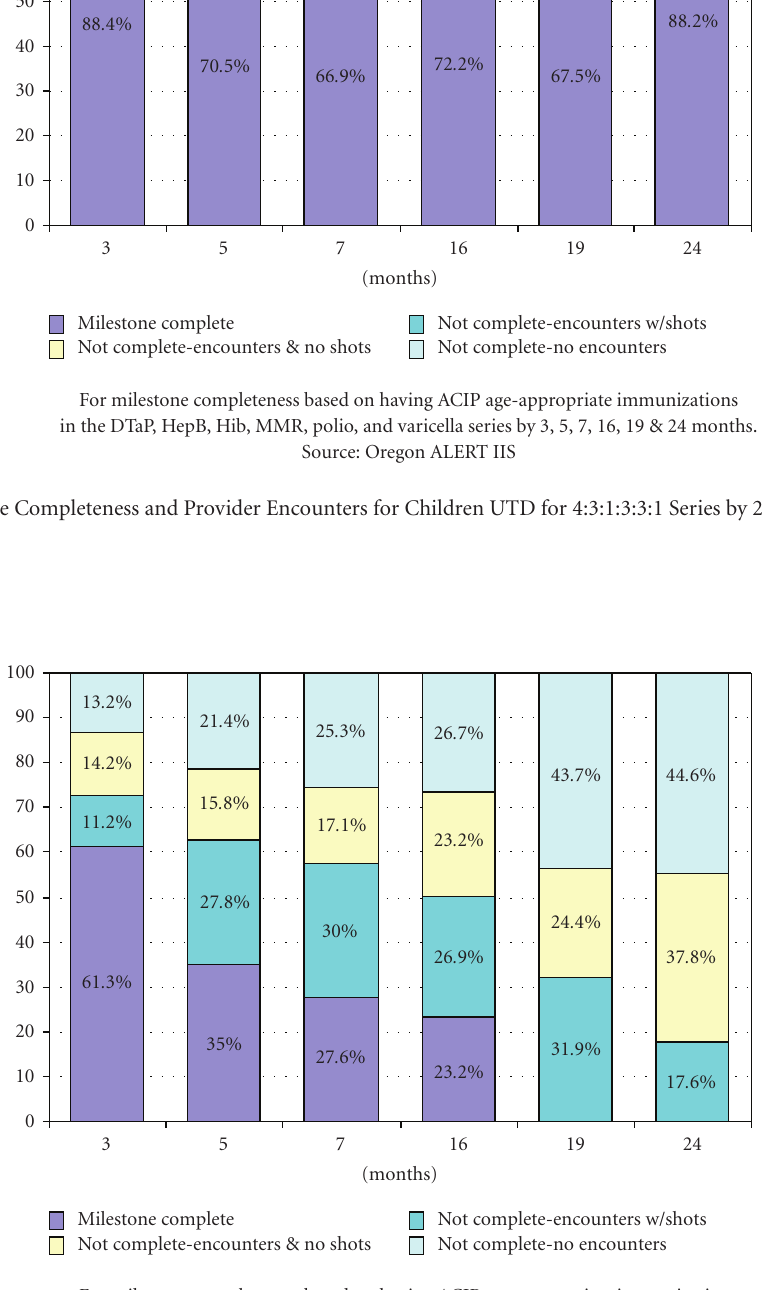
Figure 5: Milestone Completeness and Provider Encounters for Children Non-UTD for 4:3:1:3:3:1 Series by 24 to 35